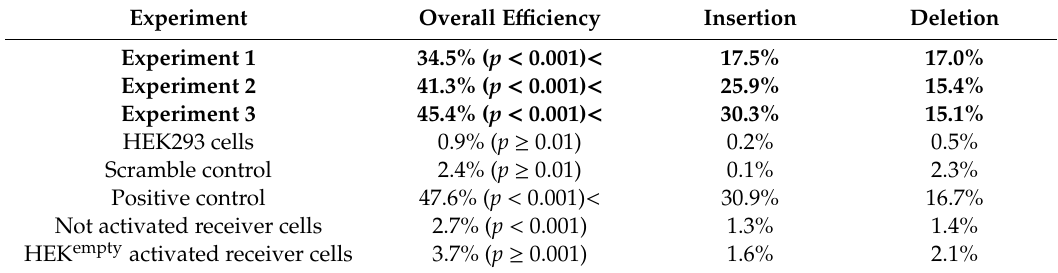
Table 3. E ffi ciency of synNotch receptor–triggered CRISPR / Cas9-mediated gene editing in three independent experiments (bold) and five control conditions (regular font).